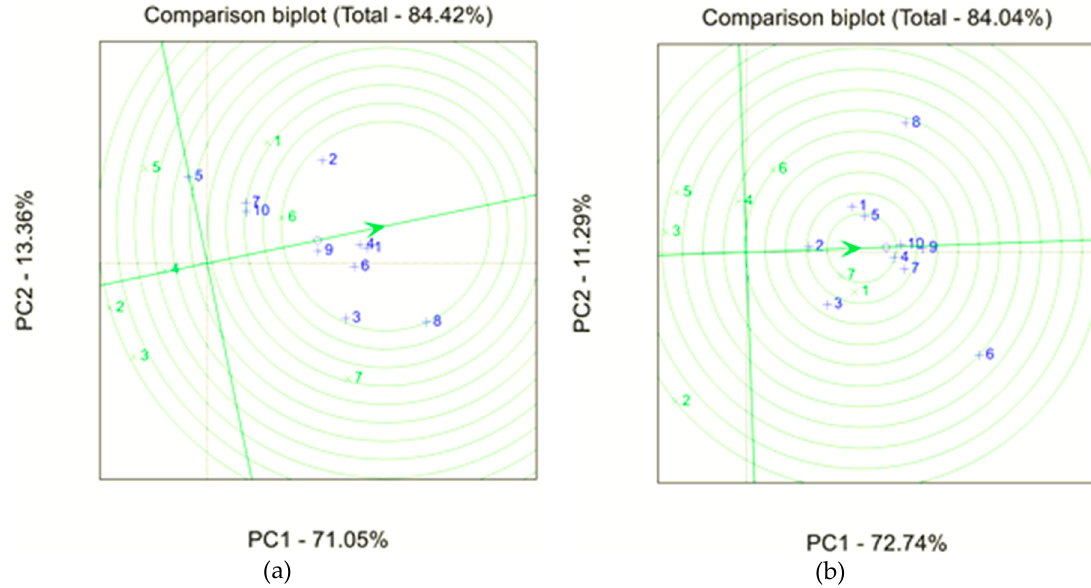
Figure 3. Genotype and genotype by environment (GGE) biplot for crop yield at ( a ) the low crop density (LCD) and ( b ) the high crop density (HCD) of the seven hybrids (x codes) across 10 environments (+ codes).